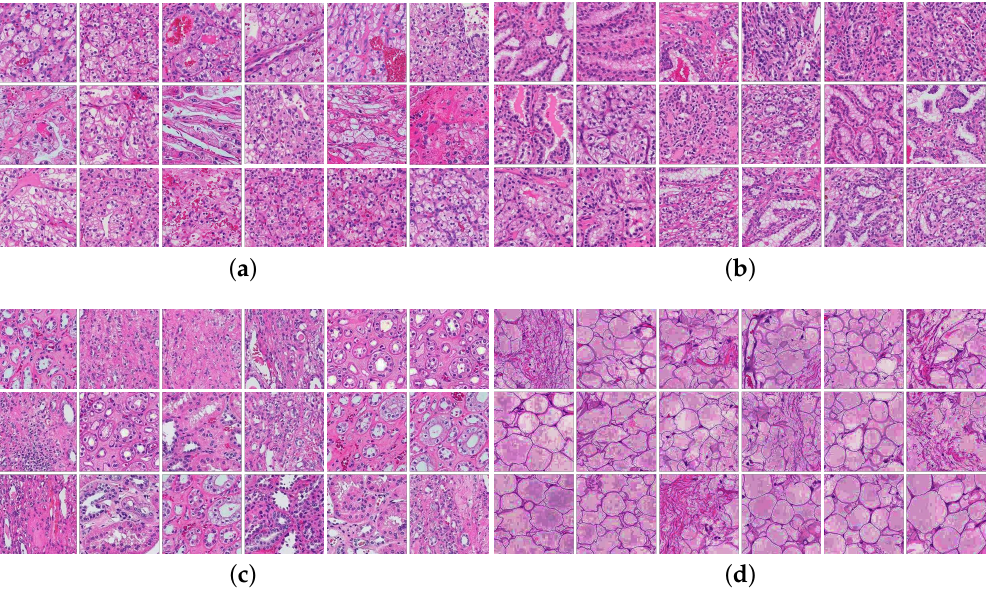
Figure 9. Samples of color-normalized extracted patches from different classes: ( a ) clear cell patches; ( b ) clear cell papillary patches; ( c ) parenchyma patches; and ( d ) fat